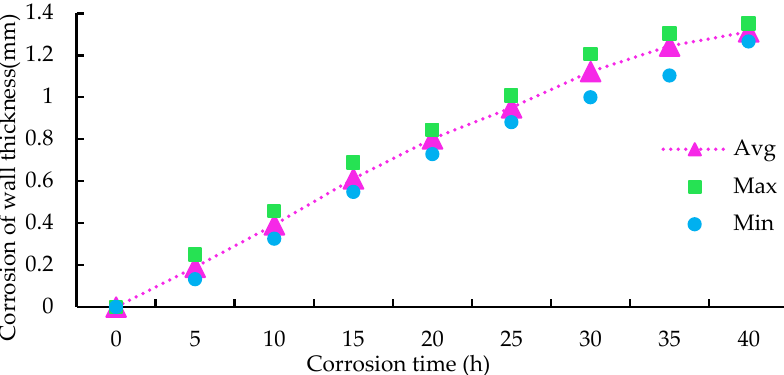
Figure 6. Relationship between the wall thickness and the corrosion time.